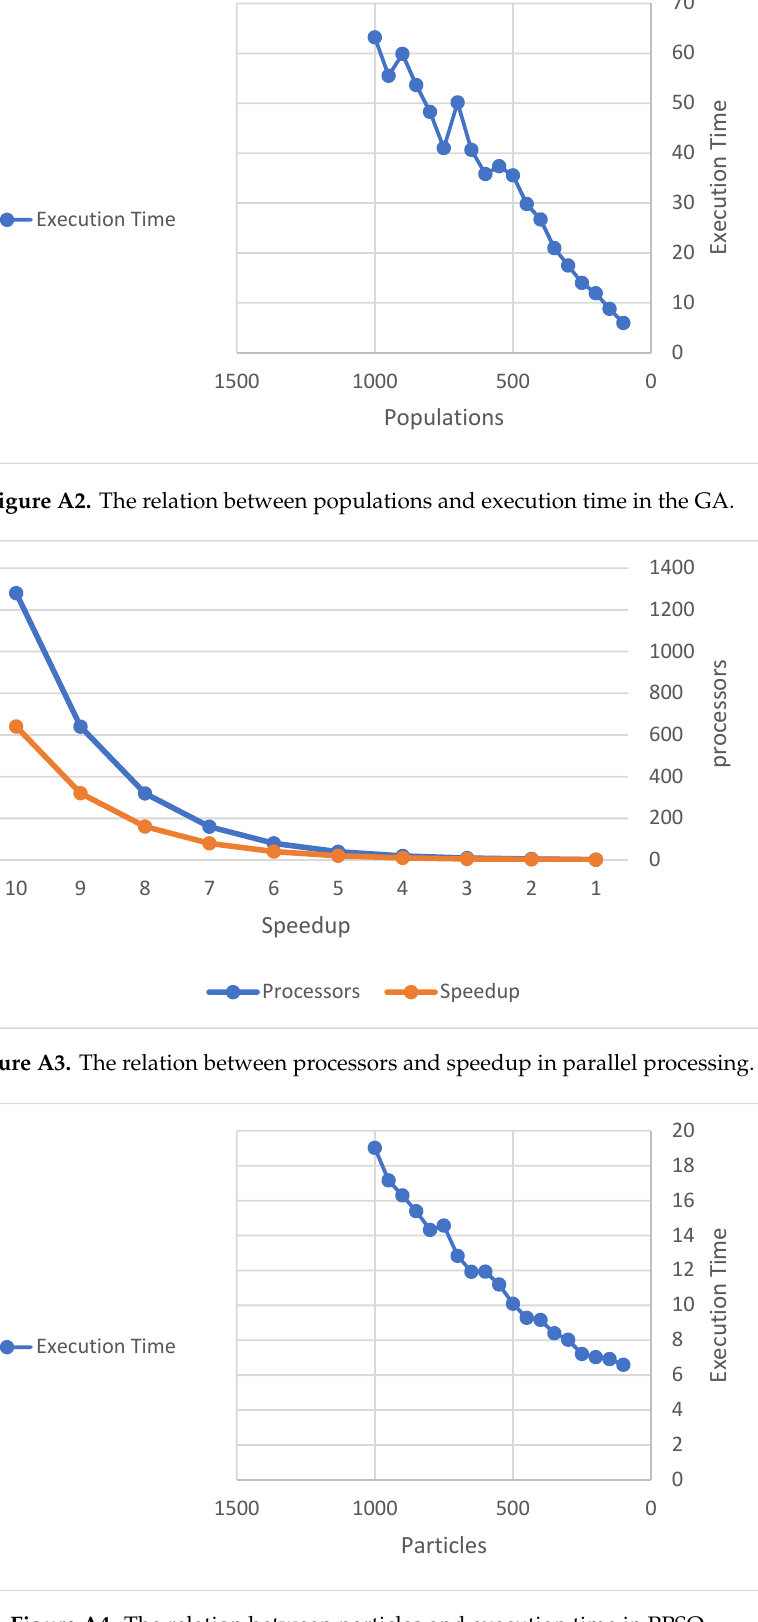
Figure A4. The relation between particles and execution time in PPSO.